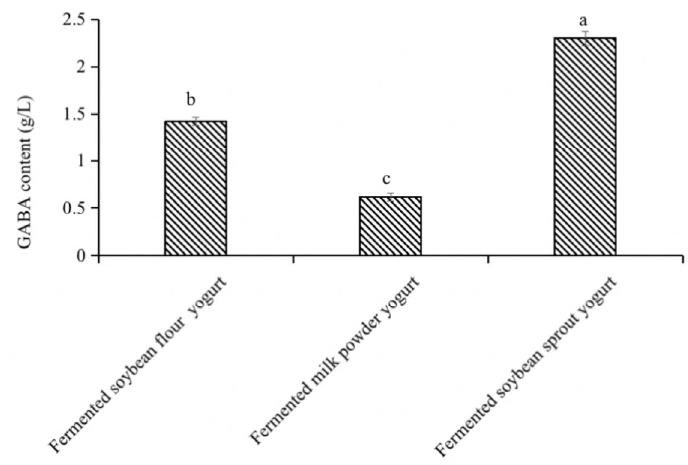
Figure 4. GABA content in different types of yogurts. a, b, and c in the figure represent GABA level of three products were significantly different.